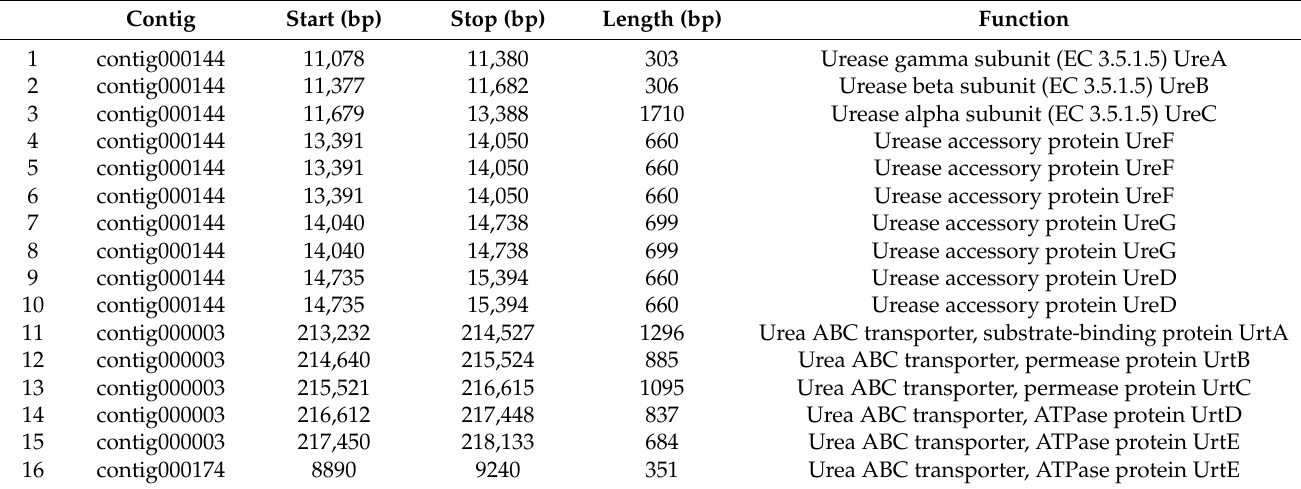
Table A10. Dactylosporangium sp. AC04546 urease and urea transporter putative genes identified using RAST server. Contig